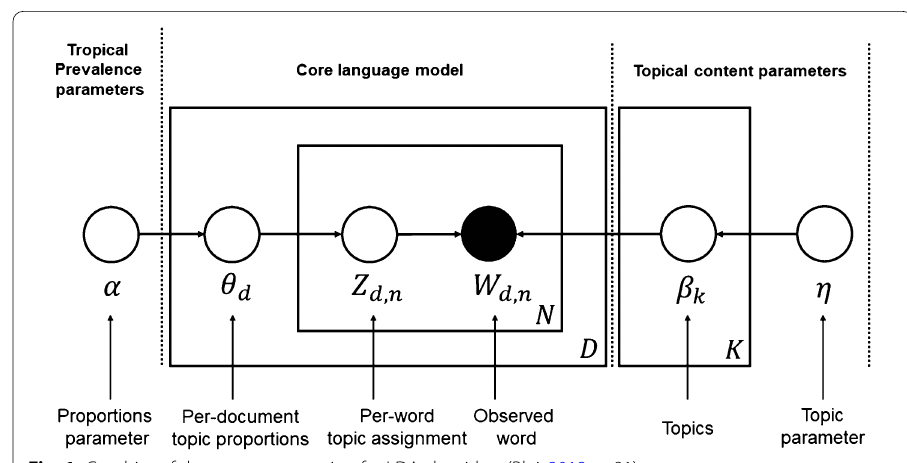
Fig. 1 Graphics of document generation for LDA algorithm (Blei, 2012, p.